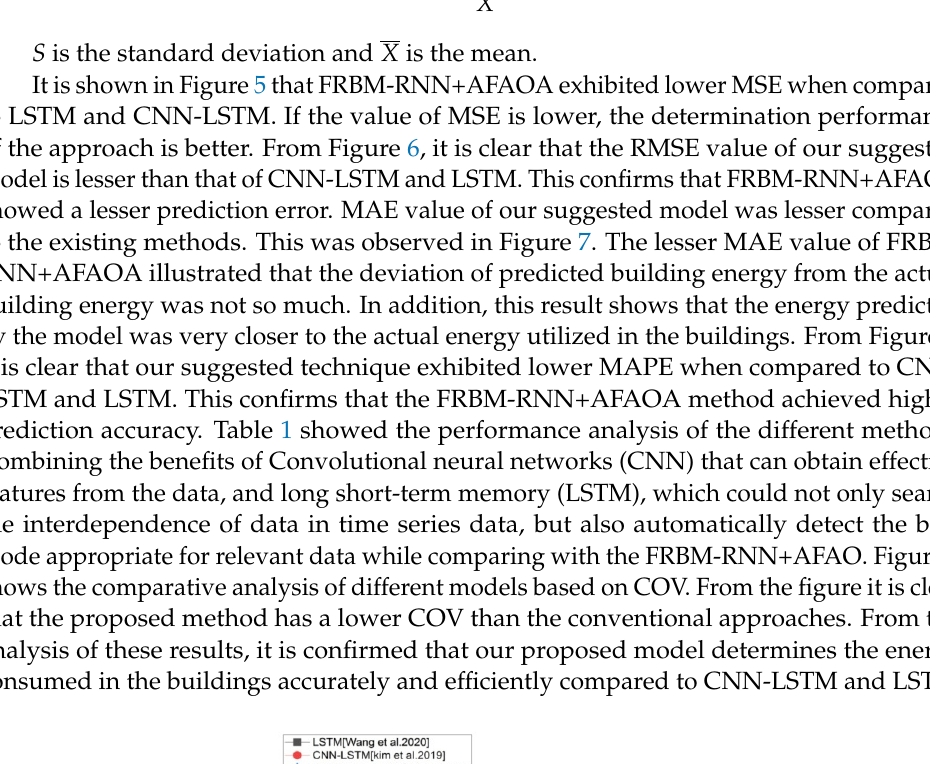
Figure 6. Graphical analysis of various models based on RMSE [Source: Author].